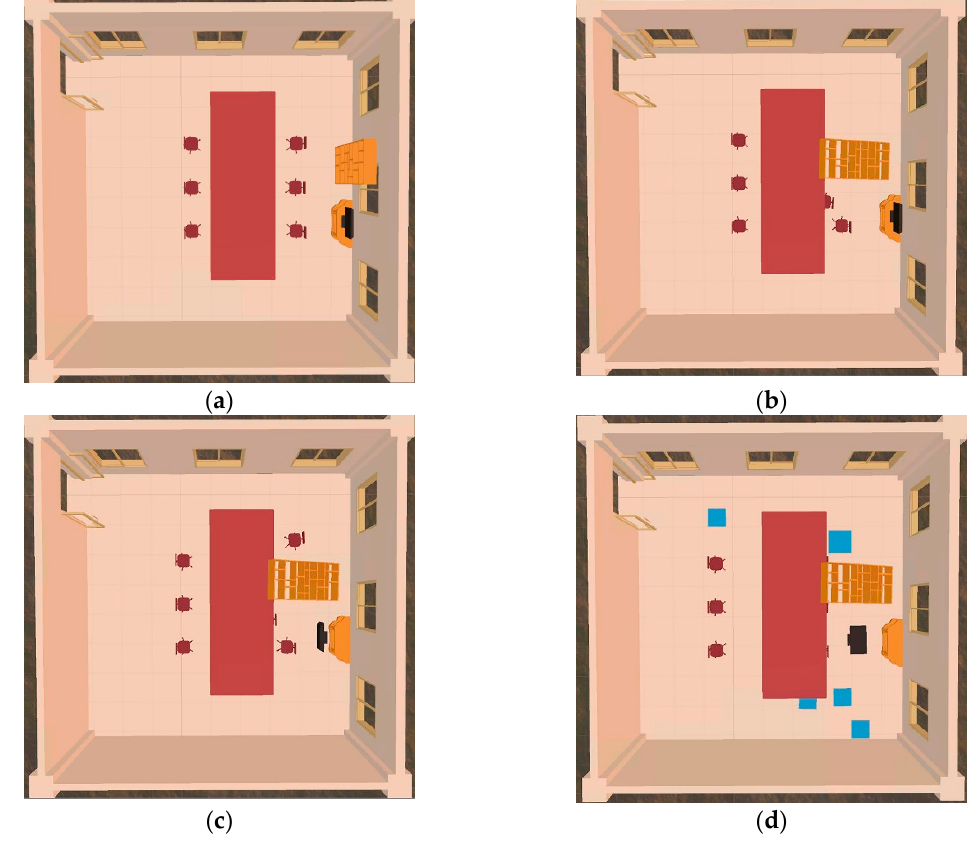
Figure 13. Constructed indoor scenes for different earthquake levels, ( a ) original scene; ( b ) minor earthquake; ( c ) moderate earthquake; ( d ) severe earthquake.